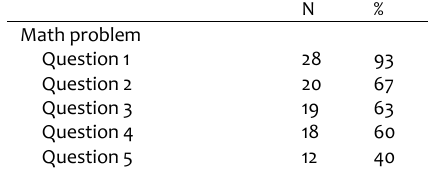
Table 2. The distribution of the answers of gifted students